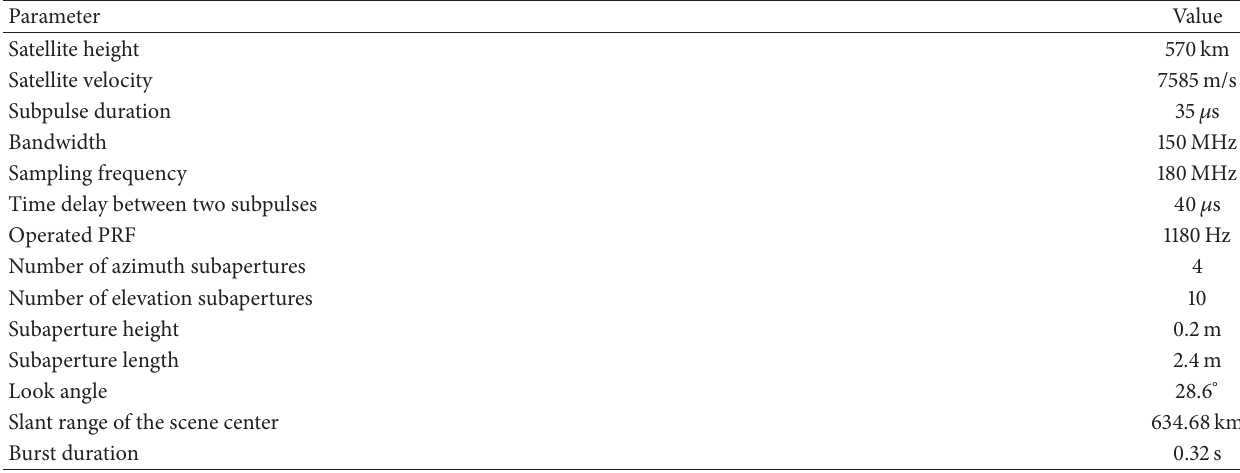
Table 1: Simulation parameter.